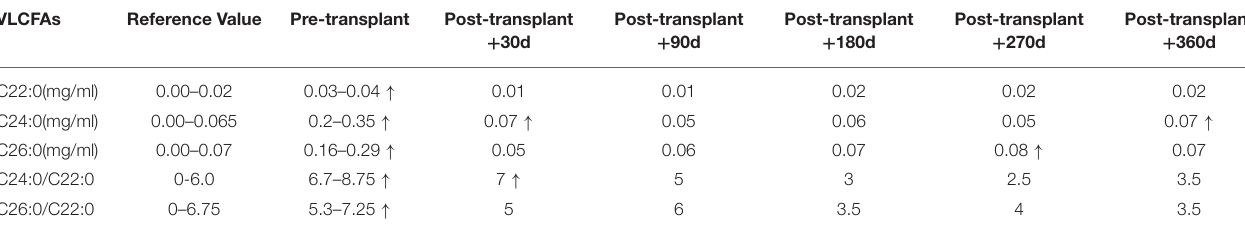
TABLE 1 | Changes of plasma VLCFAs before and after hematopoietic stem cell transplantation. VLCFAs Reference Value Pre-transplant Post-transplant